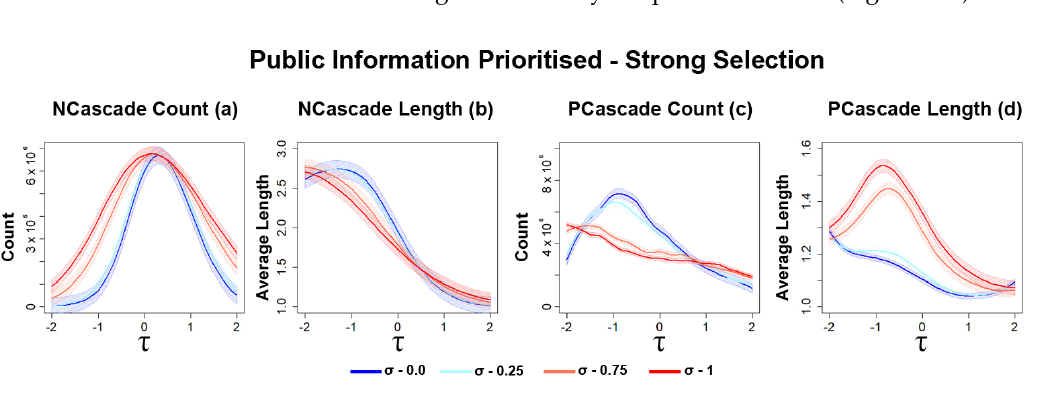
Figure 15. Significant decrease in the number of P cascades occurs when public information is prioritised and selection is strong. For both cascade types, each graph represents either the number or average length of each cascade type. With strong selection and public information, significantly more cascades were recorded during simulations; however, increasing diversity of opinion has a significant impact on the number of P cascades that occurs during simulations. Data obtained by running the model for 10 8 steps with p = 0.75 and q = 0.25 and a δ setting of 0.1. τ represents the decision threshold. σ represents opinion diversity. Shading represents level of standard error calculated for each dataset. Data interpolated utilising RStudio [22]. Plots produced via RStudio utilising code found in Appendix